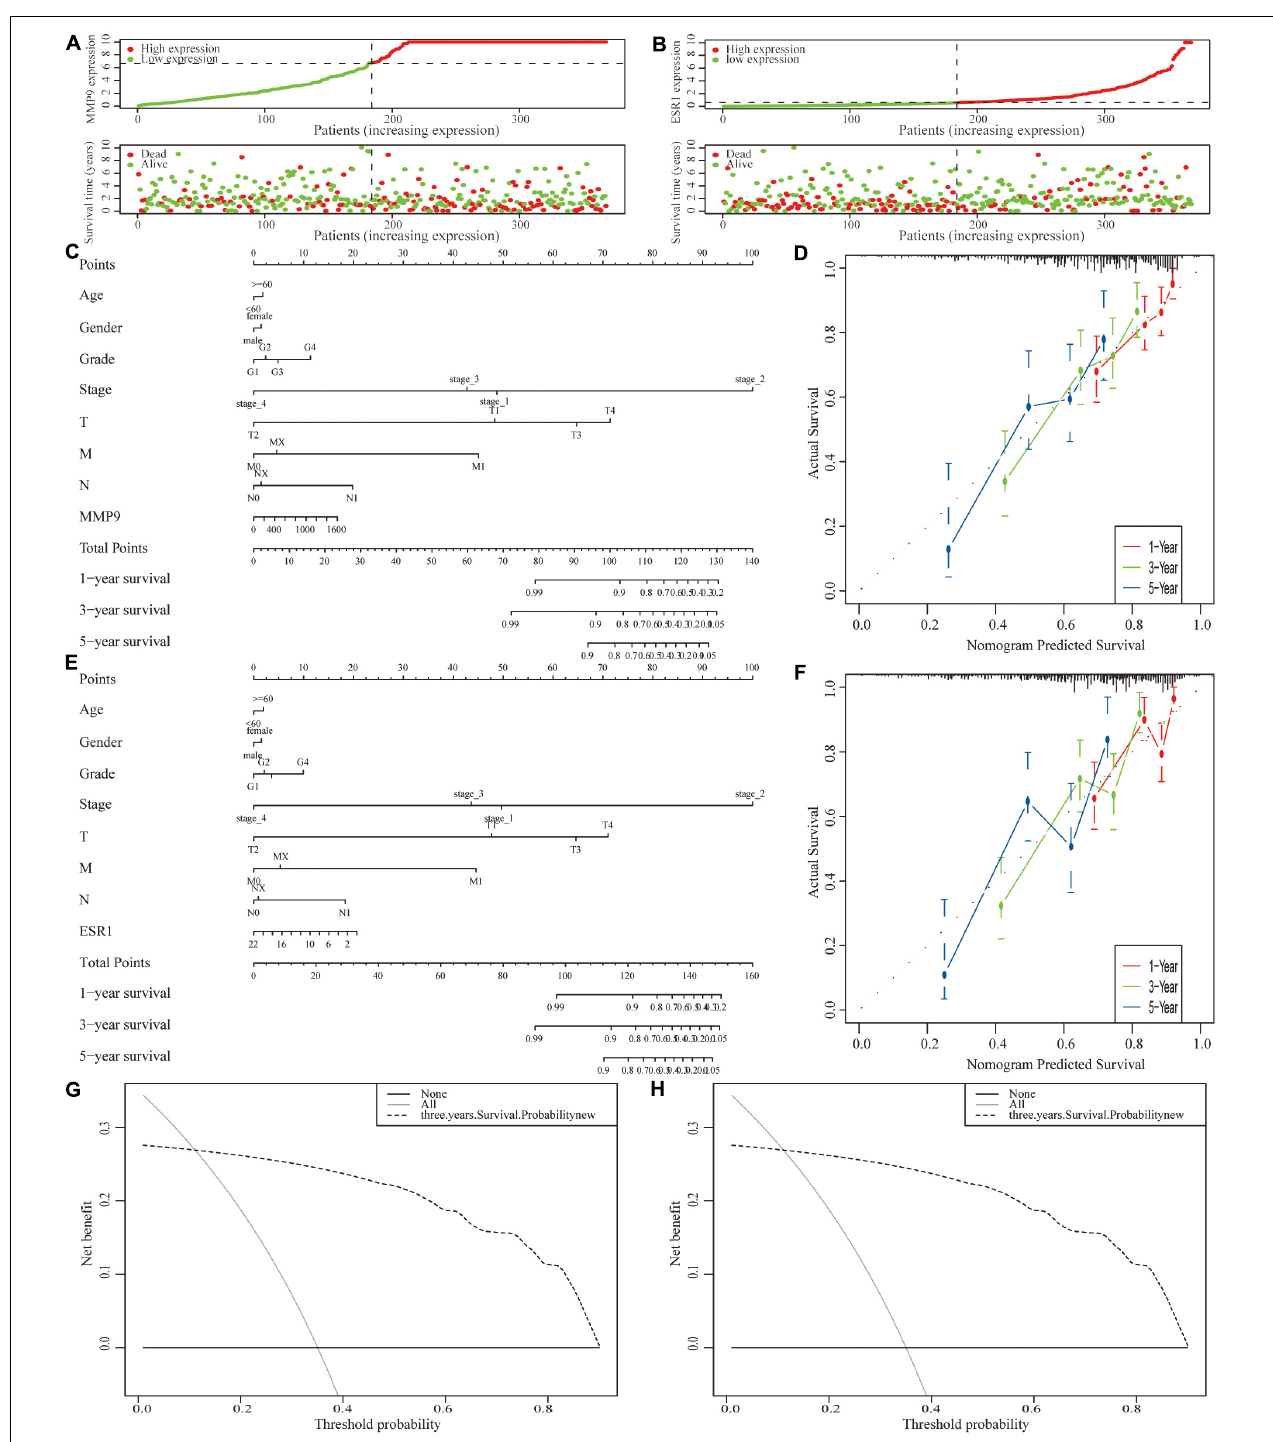
FIGURE 9 | Construction of a clinical prognostic model for patients with hepatocellular carcinoma (HCC). (A,B) Risk factor correlation diagram of the differentially expressed immune-related genes (IRGs). (C) A nomogram was constructed by combining the expression level of MMP9 with clinicopathological features. (D) Calibration curves of the nomogram constructed using the MMP9 gene; the horizontal coordinates are the survival statistics predicted by the nomogram and the vertical coordinates are the actual observed survival situation, each curve was repeated 1,000 times. The curves showed that the nomogram had a good ability to predict prognosis of patients at 1-, 2-, and 3-year. (E) A nomogram was constructed by ESR1 expression with clinicopathological features. (F) Calibration curve of the nomogram constructed using the ESR1 gene. (G,H) Decision curve analysis (DCA) of the nomograms.